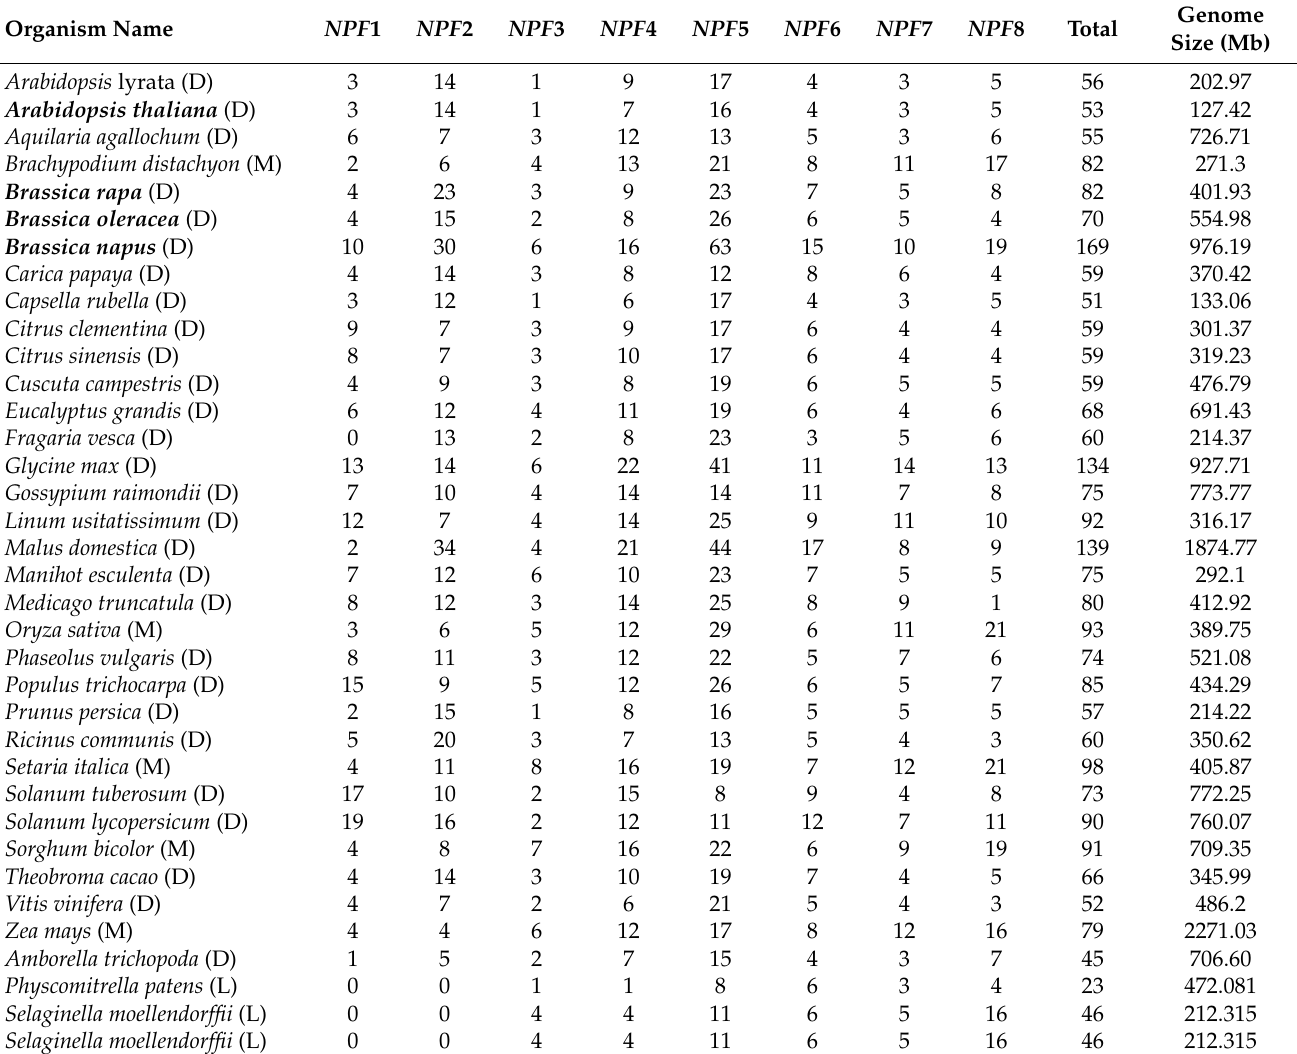
Table 2. Copy number variations (CNVs) of the NPF genes in 36 plant